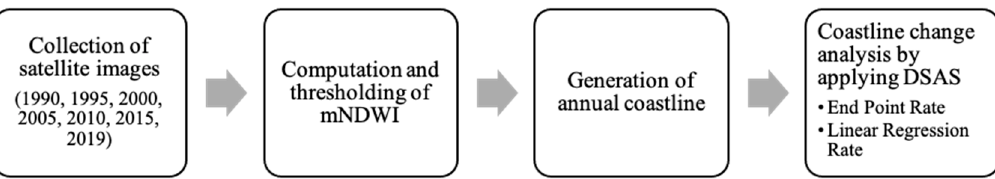
Figure 4. Flowchart of the research.